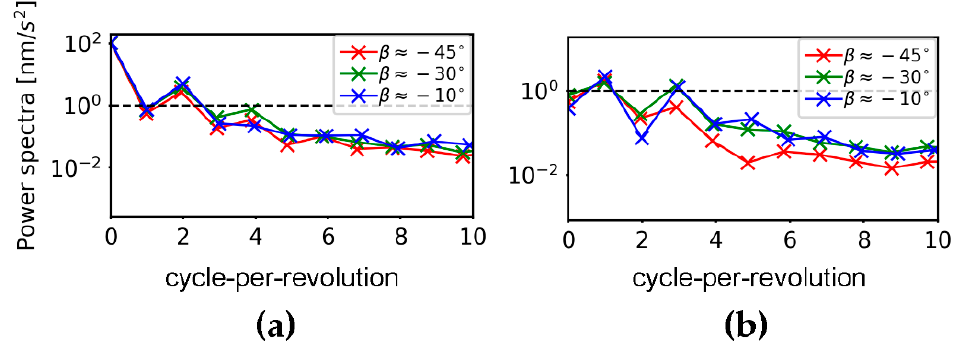
Figure 4. Power spectra of the reconstructed SRP accelerations of ABW solutions in ( a ) D and ( b ) B directions, respectively. (The dashed line in the above figures refers to 1 nm/s 2 ).